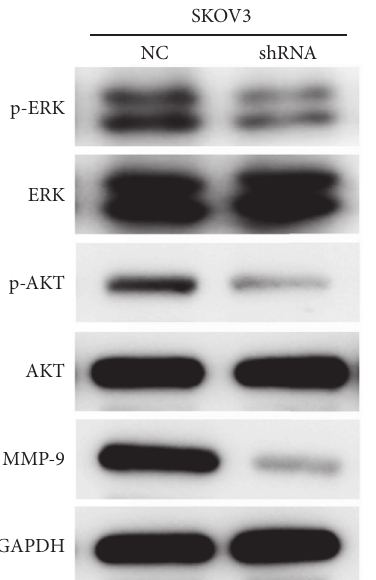
Figure 6: Knockdown of MIR4697HG decreased the levels of MMP-9, phosphorylated ERK, and AKT in SKOV3 cells. SKOV3 cells with (shRNA group) or without (NC group) MIR4697HG knockdown were subject to protein extraction. The extracted proteins were then assayed using western blot analysis of matrix metalloproteinase 9 (MMP-9), ERK (phosphorylated or not), and AKT (phosphorylated or